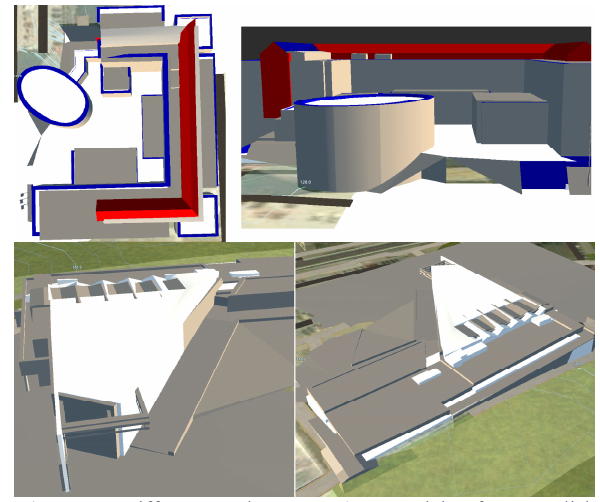
Figure 8 . Differences between 3D models from Polish Geoportal and